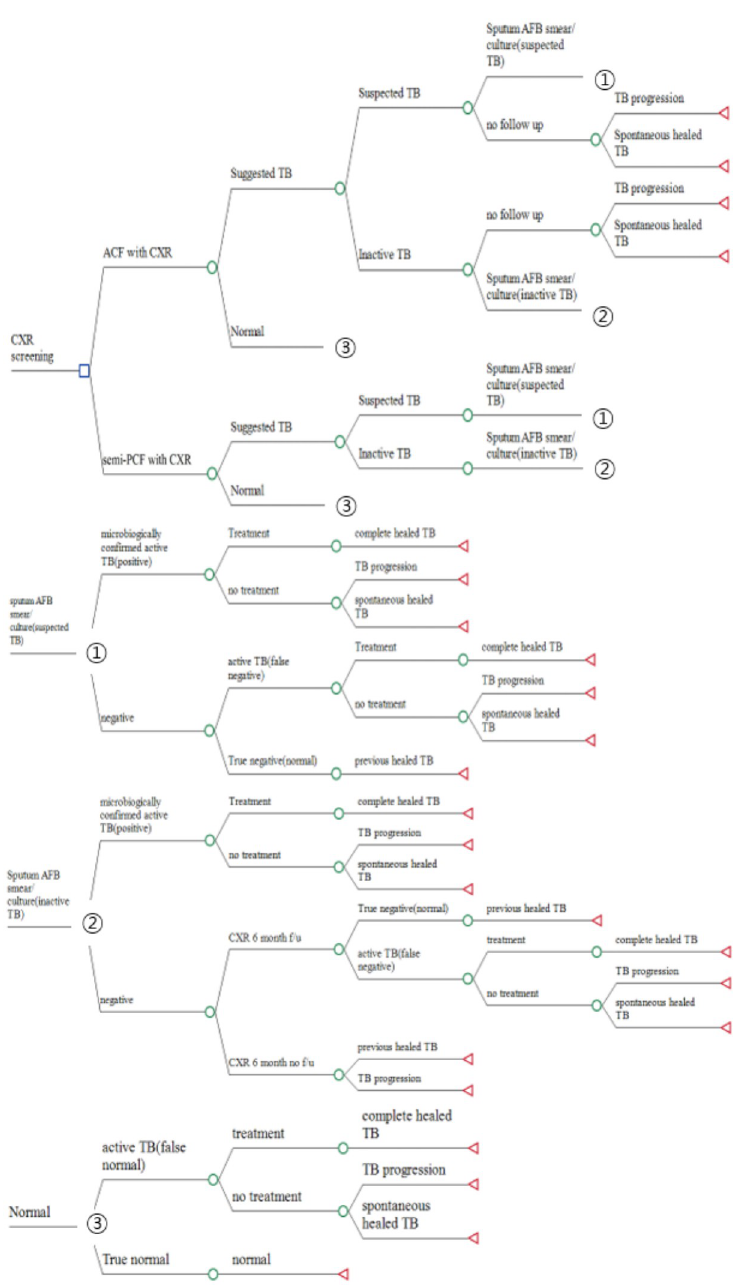
Fig 1. TreeAge model outline for ACF and semi-PCF. Each branch represents one possible instance. The comment below the node indicates the possibility of each node. The total cost of the branch is written next to the terminal